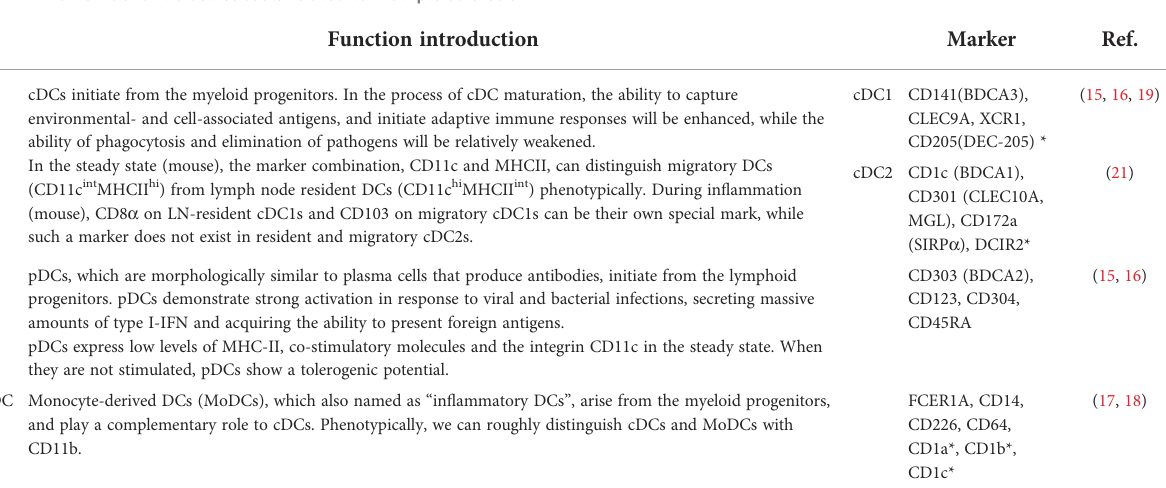
TABLE 1 Human dendritic cell subsets related to multiple sclerosis.